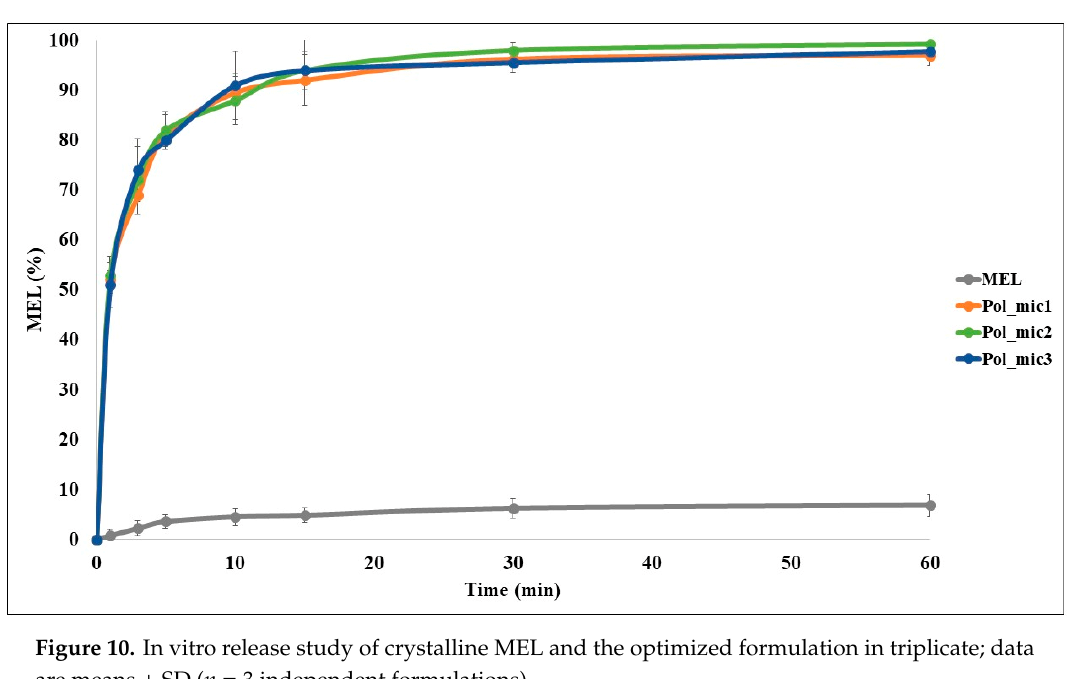
Figure 10. In vitro release study of crystalline MEL and the optimized formulation in triplicate; data are means ± SD ( n = 3 independent formulations)